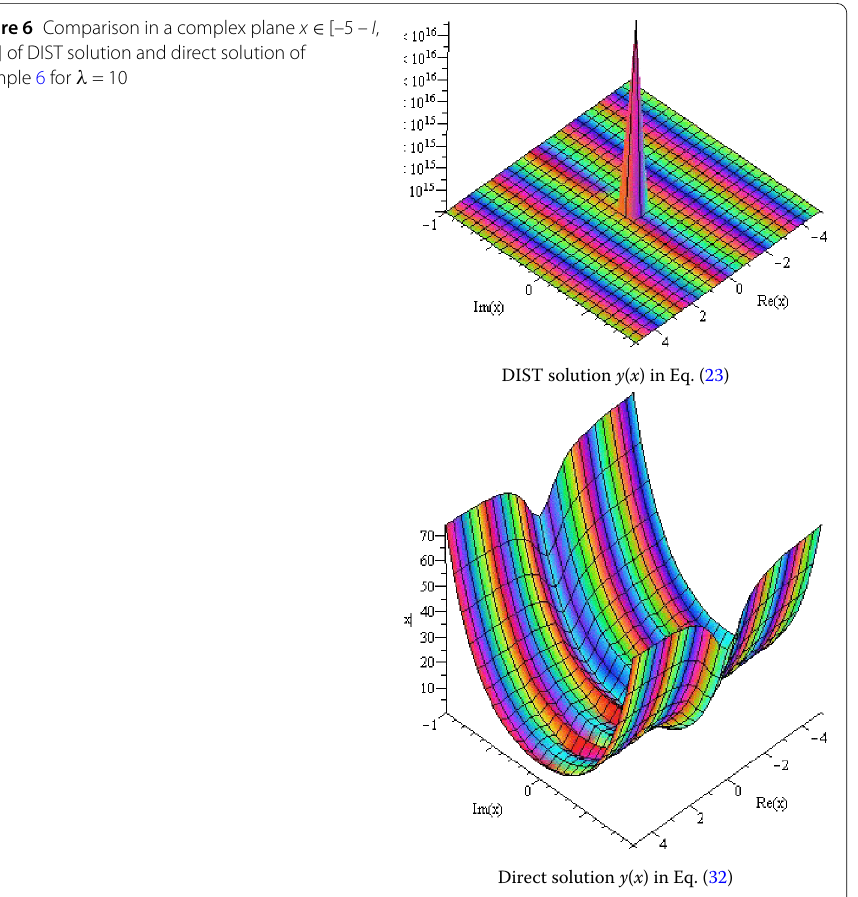
Figure 6 Comparison in a complex plane x ∈ [–5 – I , 5 + I ] of DIST solution and direct solution of Example 6 for λ =